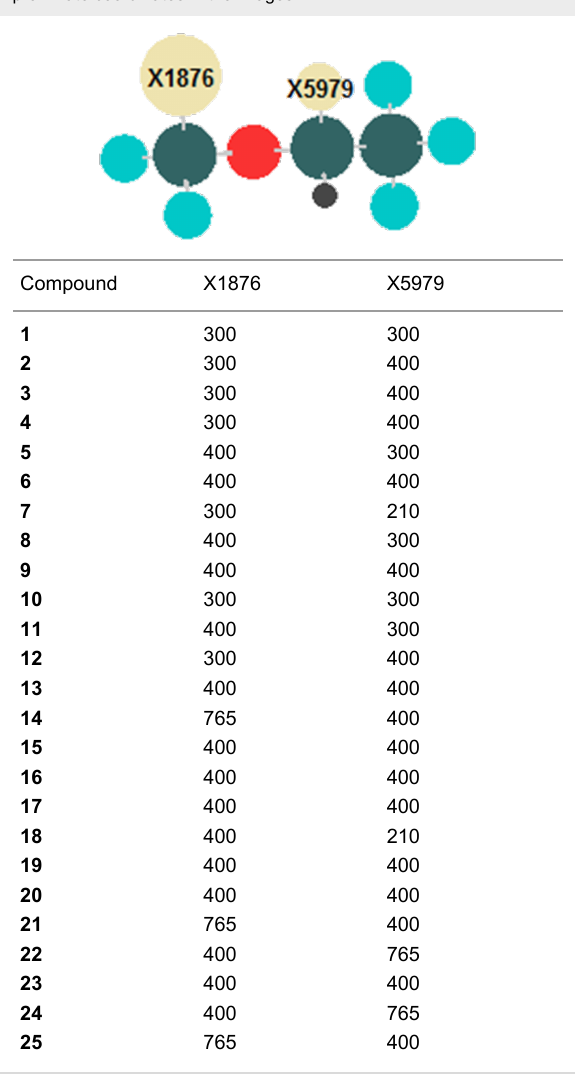
Table 6: Reduced matrix with the selected descriptors and their ap- proximate coordinates in the images.